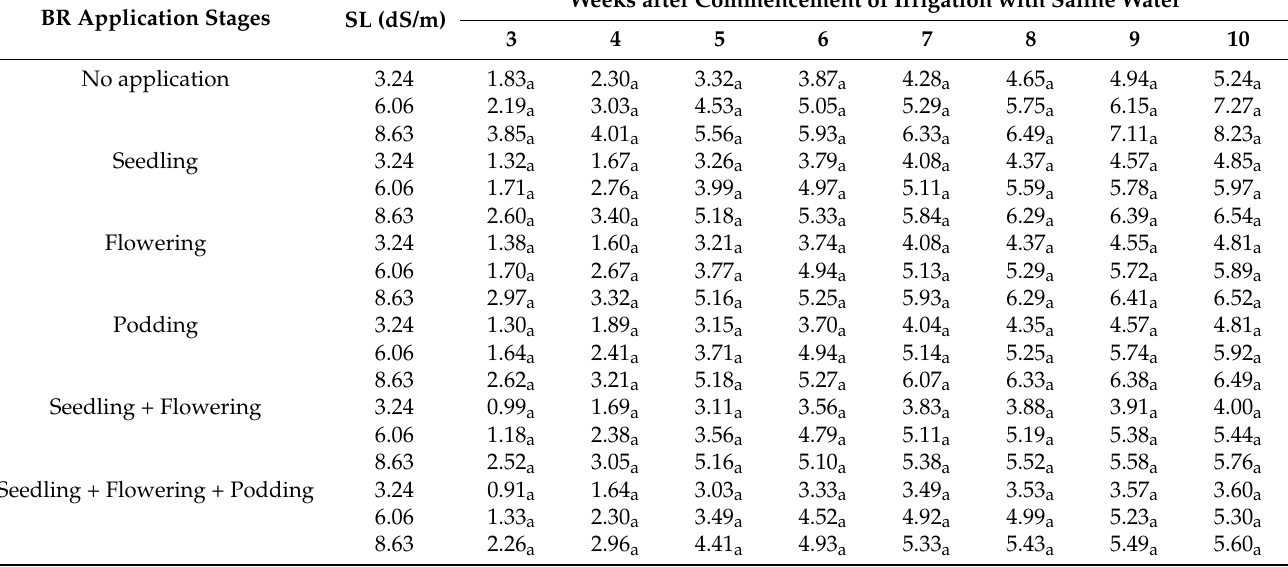
Table 6. Interaction effects of growth stages of application of 24-epibrassinolide (BR), salinity levels (SLs) and weeks after commencement of irrigation with saline water (WAST) on electrical conductivity of the saturated soil extracts (EC se s) in rhizosphere of